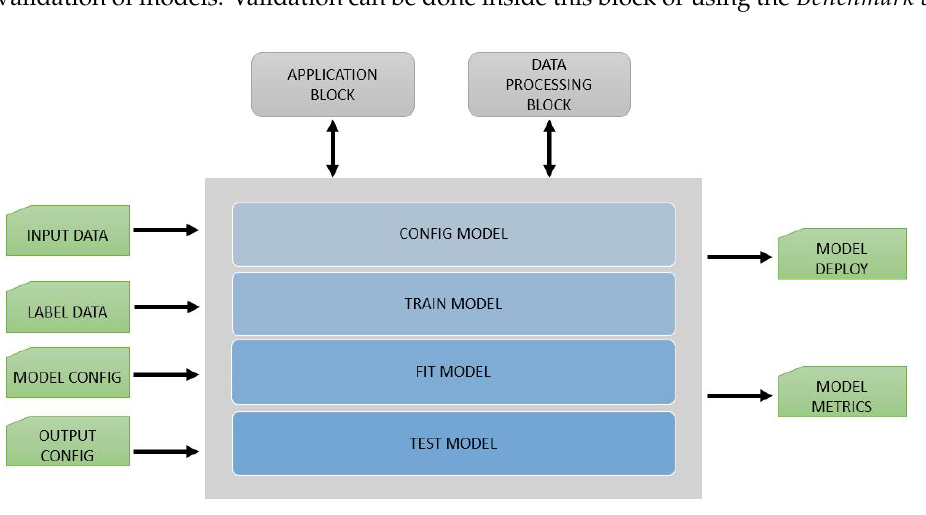
Figure 6. AI block.